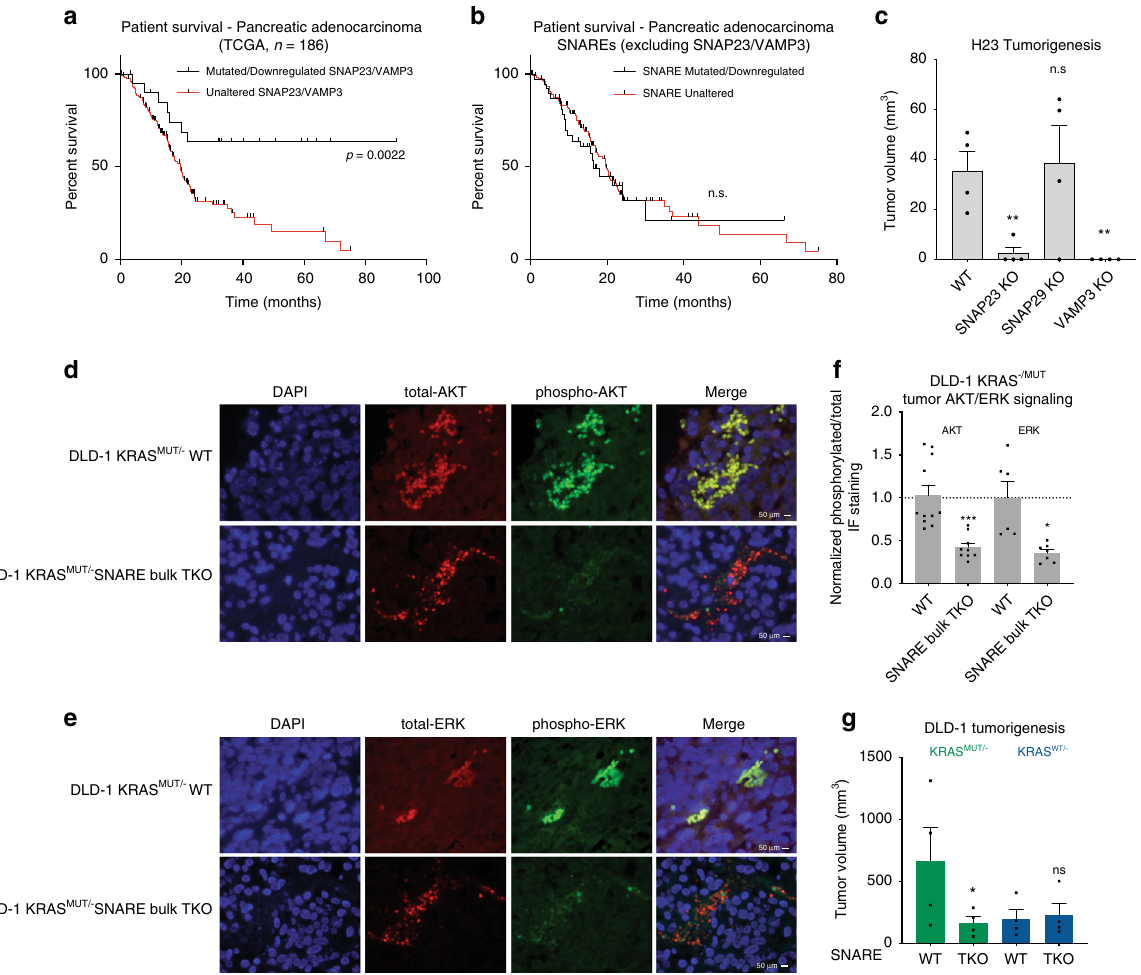
Fig. 6 SNARE-enabled transport is a vulnerability of KRAS-driven cancer. a Survival of KRAS-mutant pancreatic adenocarcinoma patients depending on mutation and expression status of SNAP23 and VAMP3 ( n = 186). b Survival of KRAS-mutant pancreatic adenocarcinoma patients depending on mutation and expression status of the 36 other SNARE proteins ( n = 162). c Subcutaneous in vivo tumor growth of H23 SHO immune de fi cient mice ( n = 4 mice/ group). d Immuno fl uorescence images of phosphorylated and total AKT in oncogenic KRAS-driven DLD-1 subcutaneous tumors. e Immuno fl uorescence images of phosphorylated and total ERK in oncogenic KRAS-driven DLD-1 subcutaneous tumors. f Quantitation of d and e . g Subcutaneous in vivo tumor growth in DLD-1 isogenic lines ( n = 4 mice/group). Error bars are